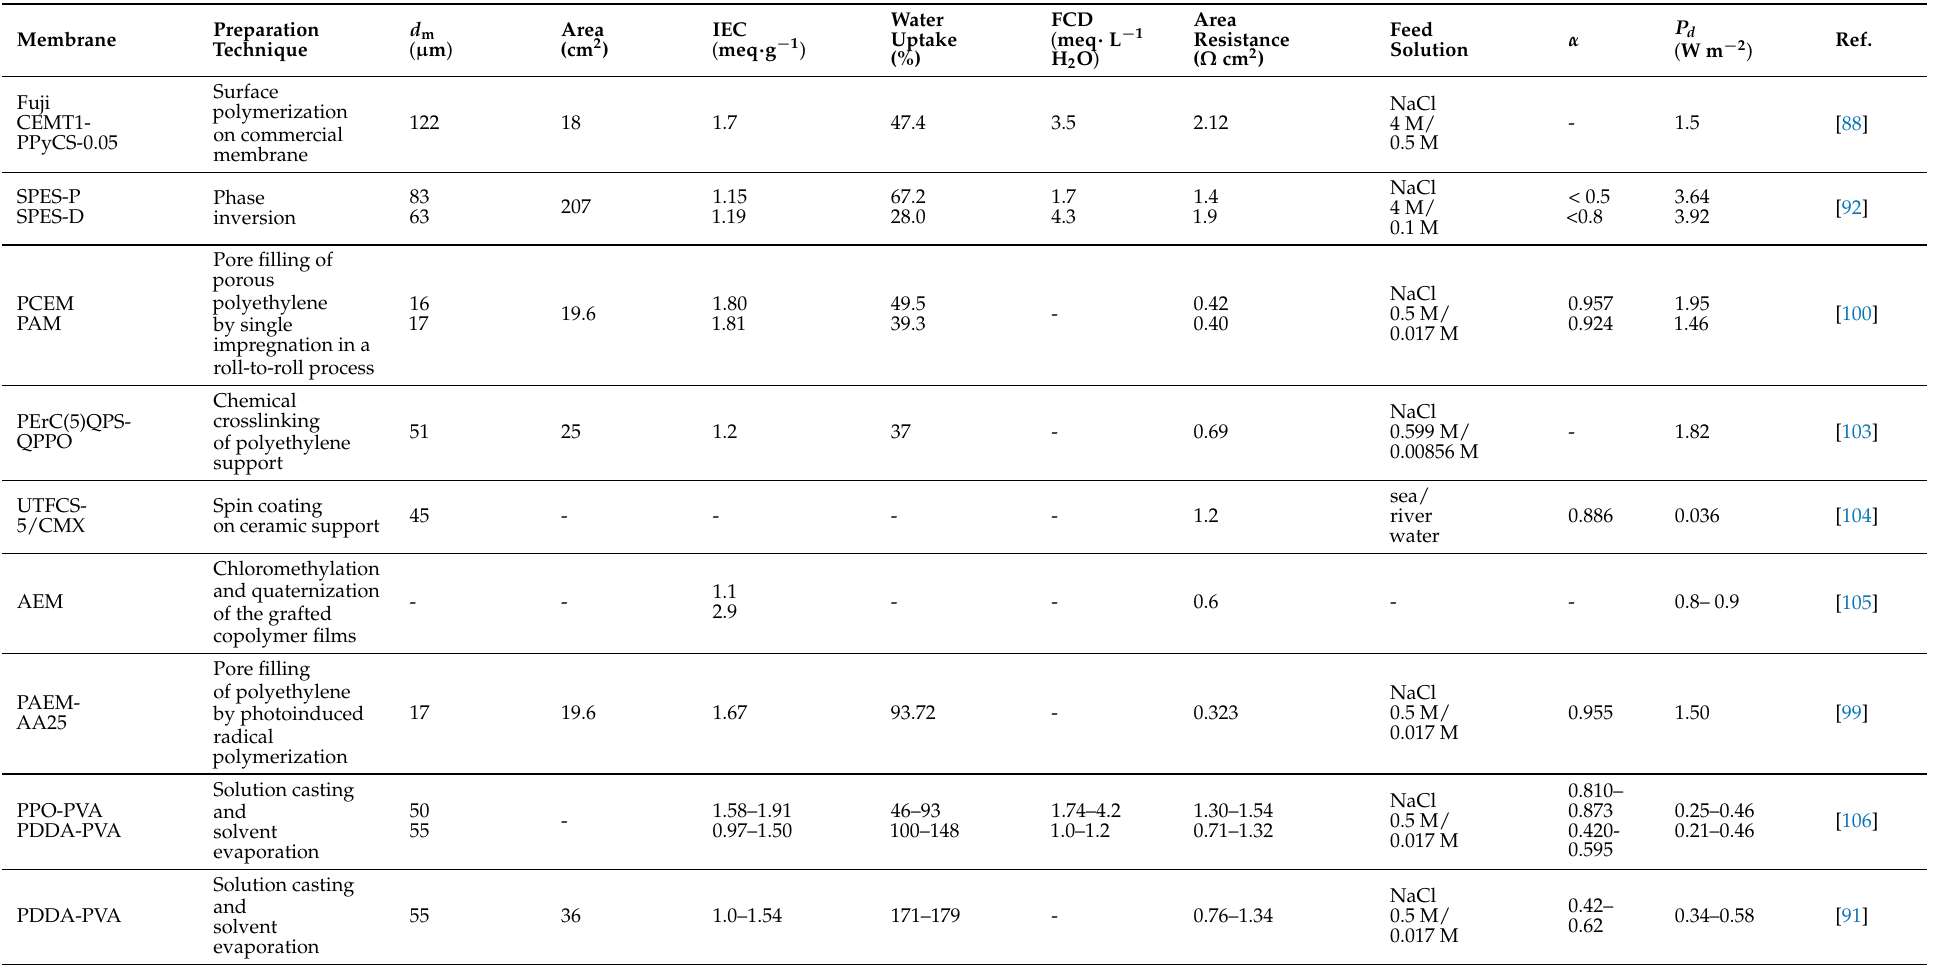
Table 3. Overview of custom-made IEMs for RED applications (The membrane denominations are taken from the respective studies).